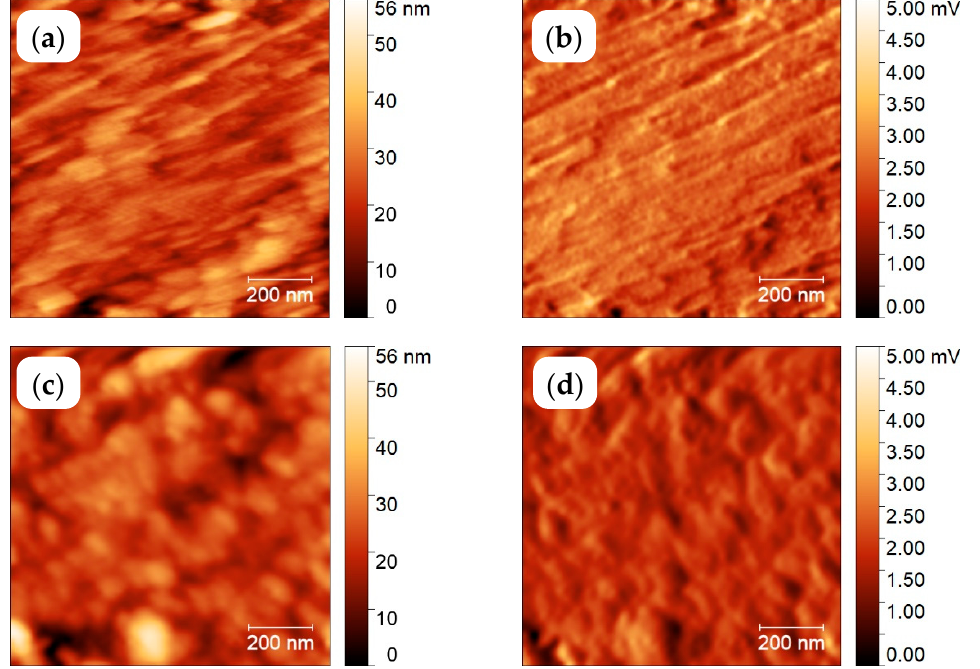
Figure 12. Topology (left) and amplitude (right) images taken at 278 K after annealing the melt of polyamide 66 (PA 66) for 1,000 s at 480 K ( a and b ) and 350 K ( c and d ).